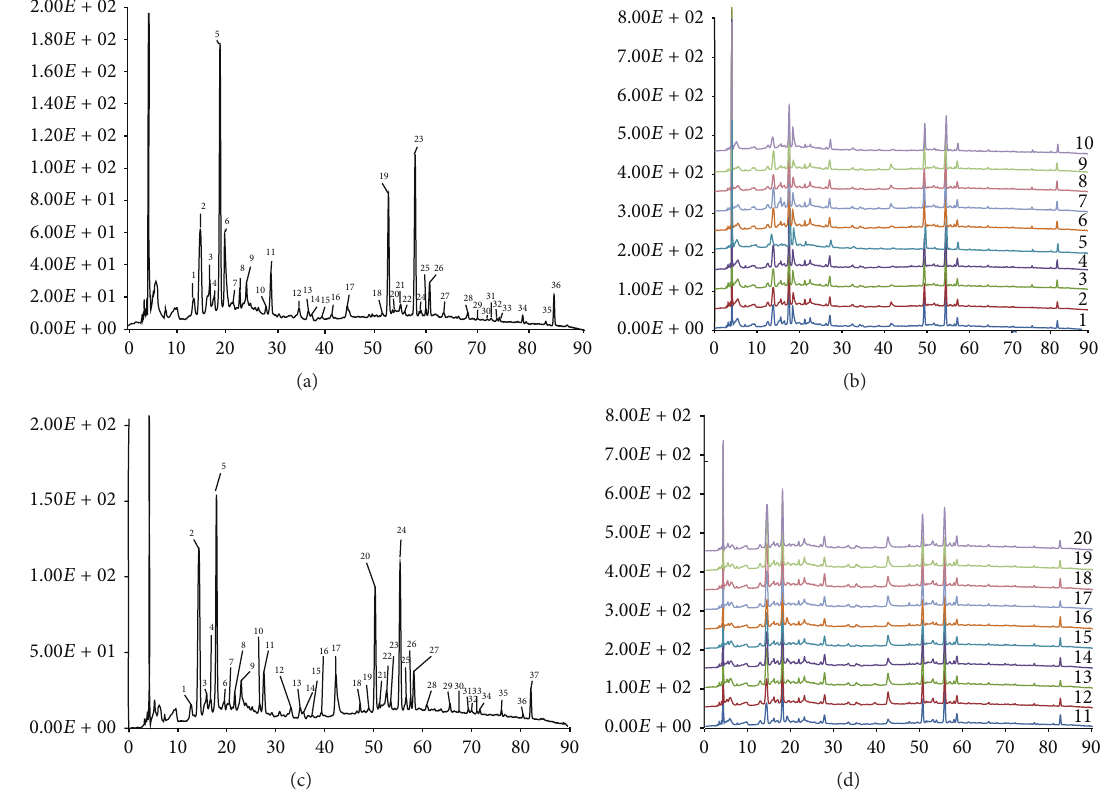
Figure1:TypicalLCprofilesof36commonpeaks(a)andcomparisonofchromatographicfingerprintsofSFPSWT(b),andtypicalLCprofiles of 37 common peaks (c) and comparison of chromatographic fingerprints of SDP SWT (d). Gallic acid (14.12min), 5-hydroxymethylfurfural (17.93min), cianidanol (27.79 min), albiflorin (36.83 min), paeoniflorin (42.57 min), ferulic acid (50.56 min), verbascoside (53.72 min), senkyunolide I (55.72 min), senkyunolide A (76.55 min), and Z -ligustilide (82.63